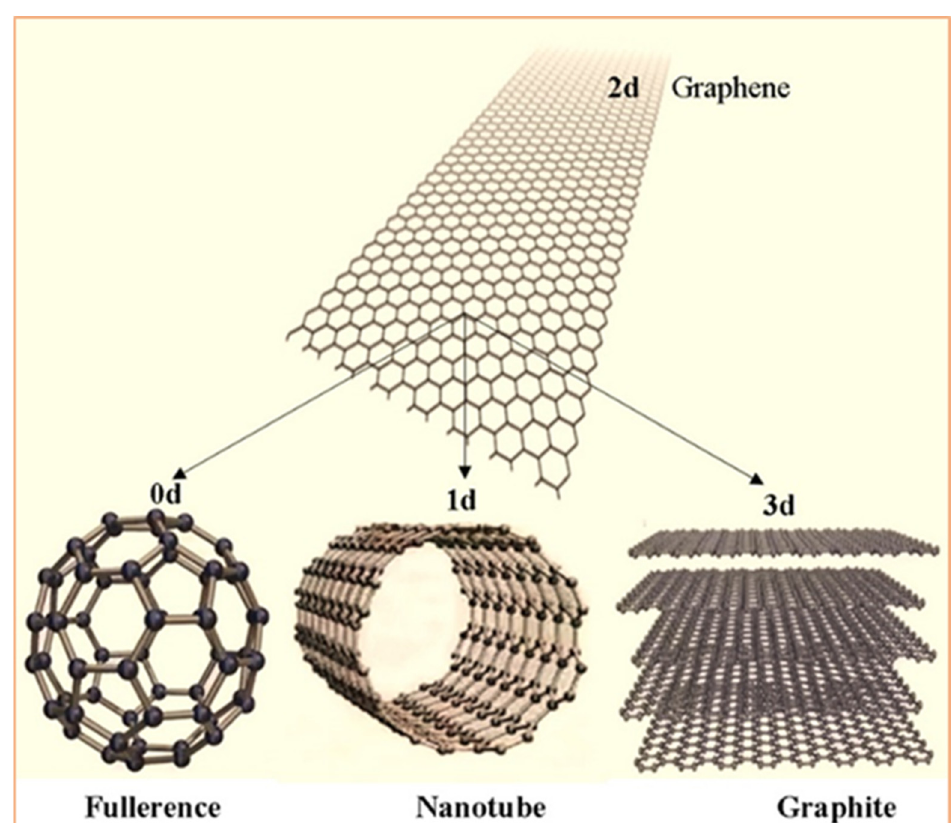
Figure 1. Crystal structures of different allotropes of carbon: graphite (3D); graphene (2D); nanotubes (1D); and fullerene (buckyballs) (0D).